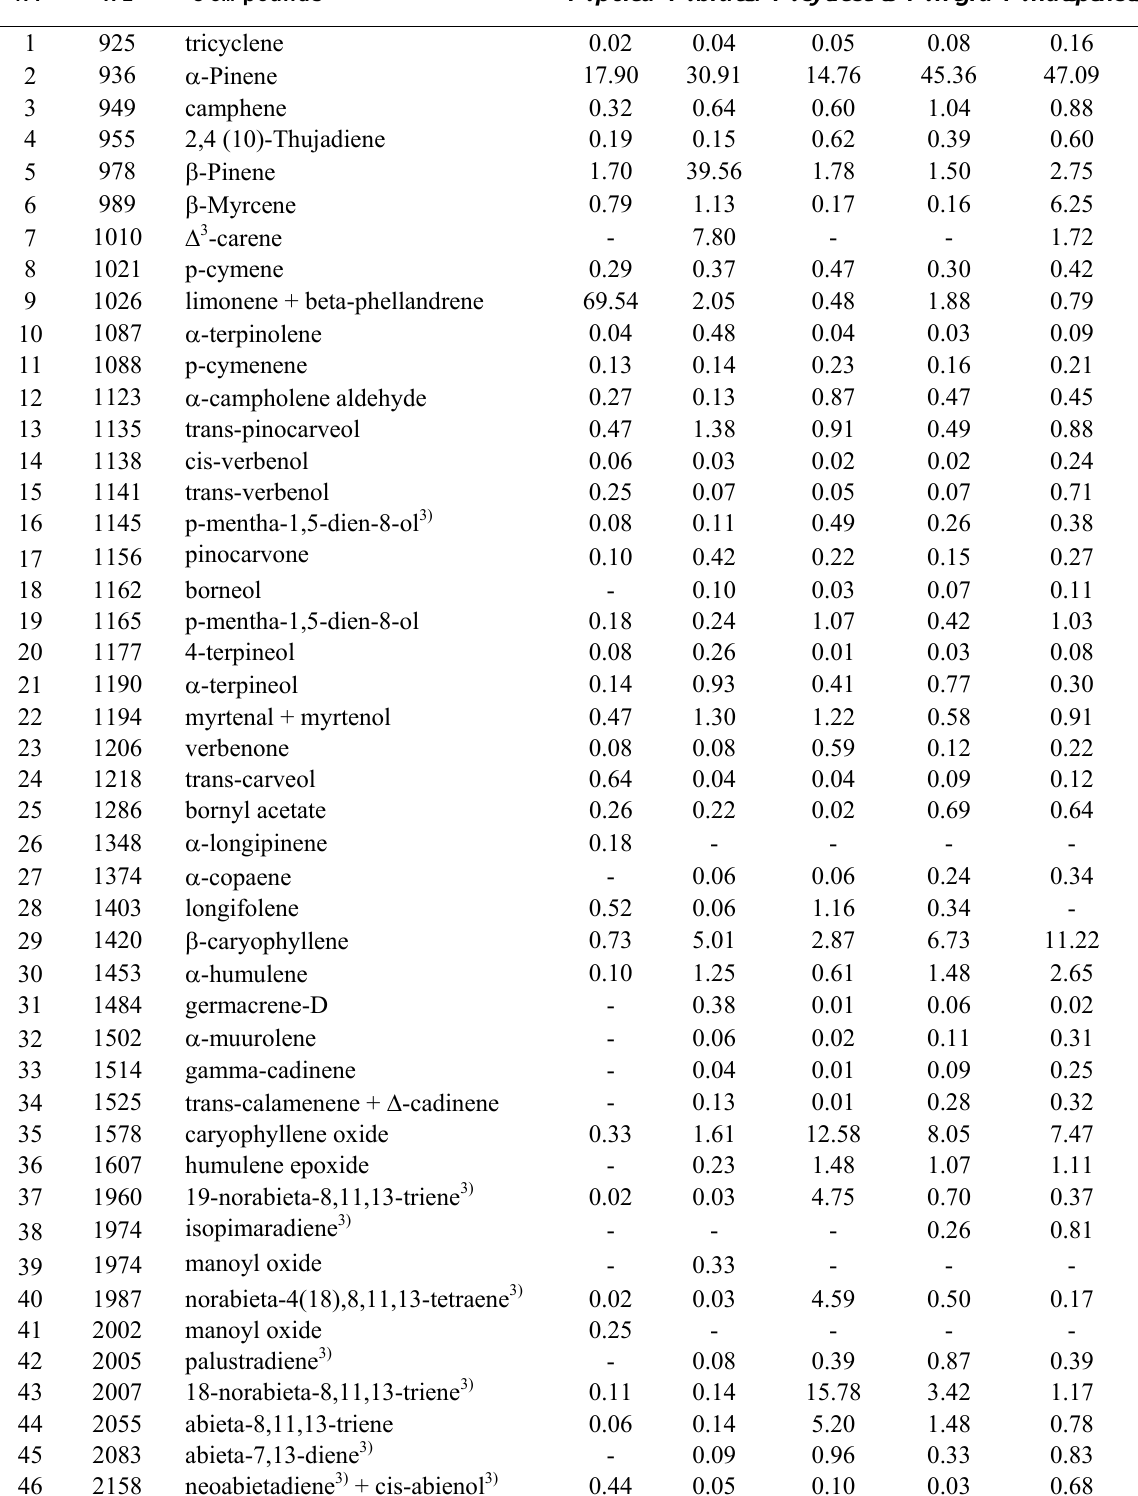
Table 1. Percent (w/w %) composition 1) of components in